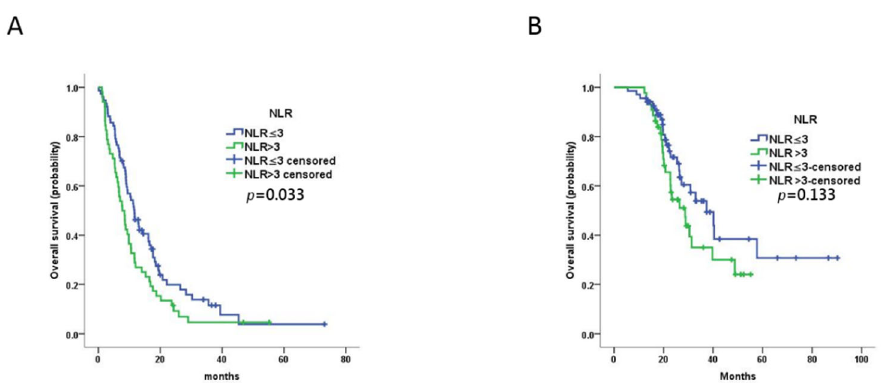
Figure 1. Prognostic value of baseline NLR in MBC patients treated with trastuzumab as first ‐ line therapy. ( A , B ) Kaplan–Meier plots of progression ‐ free survival ( A ) and overall survival ( B ) for patients assigned to NLR ‐ high ( n = 52) and NLR ‐ low ( n = 77) groups at baseline. Table 3. Univariable and multivariable analysis of progression ‐ free survival.